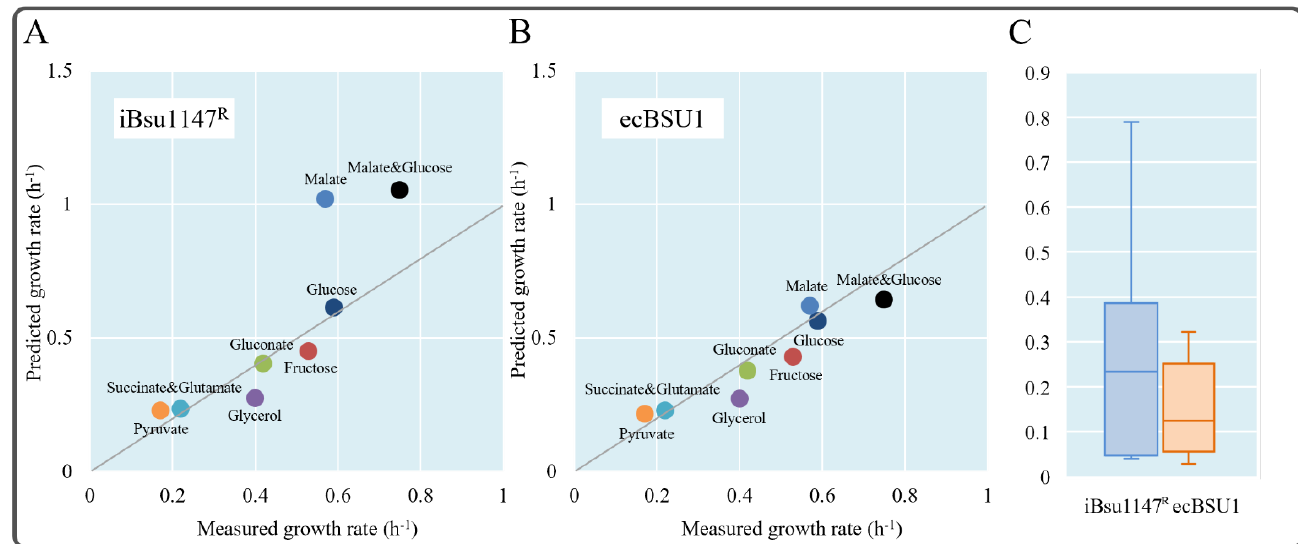
Figure 5. Predicted B. subtilis growth rates on different carbon sources using iBsu1147 R ( A ) and ecBSU1 ( B ). ( C ) Distribution of prediction errors of internal fluxes from iBsu1147 R and ecBSU1.